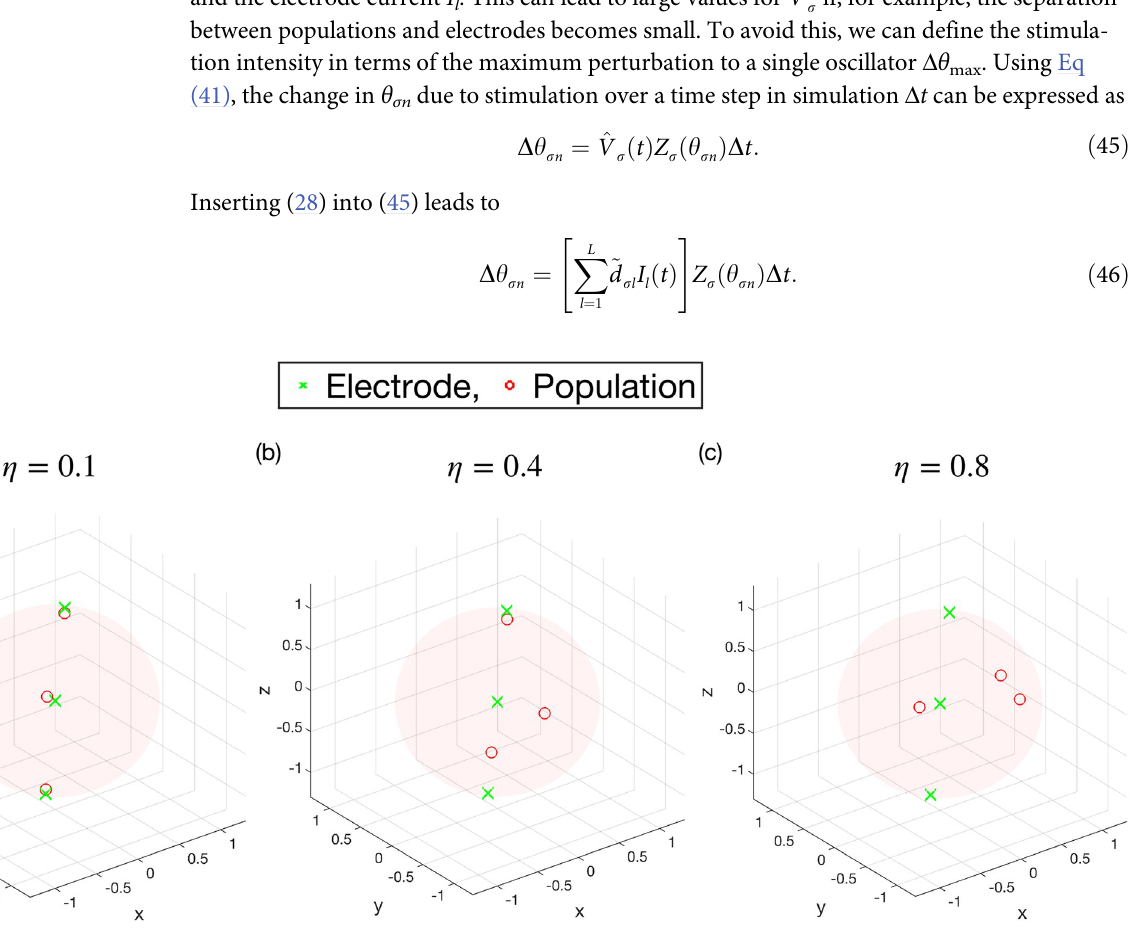
PLOS Computational Biology | https://doi.org/10.1371/journal.pcbi.1009281 August 6,